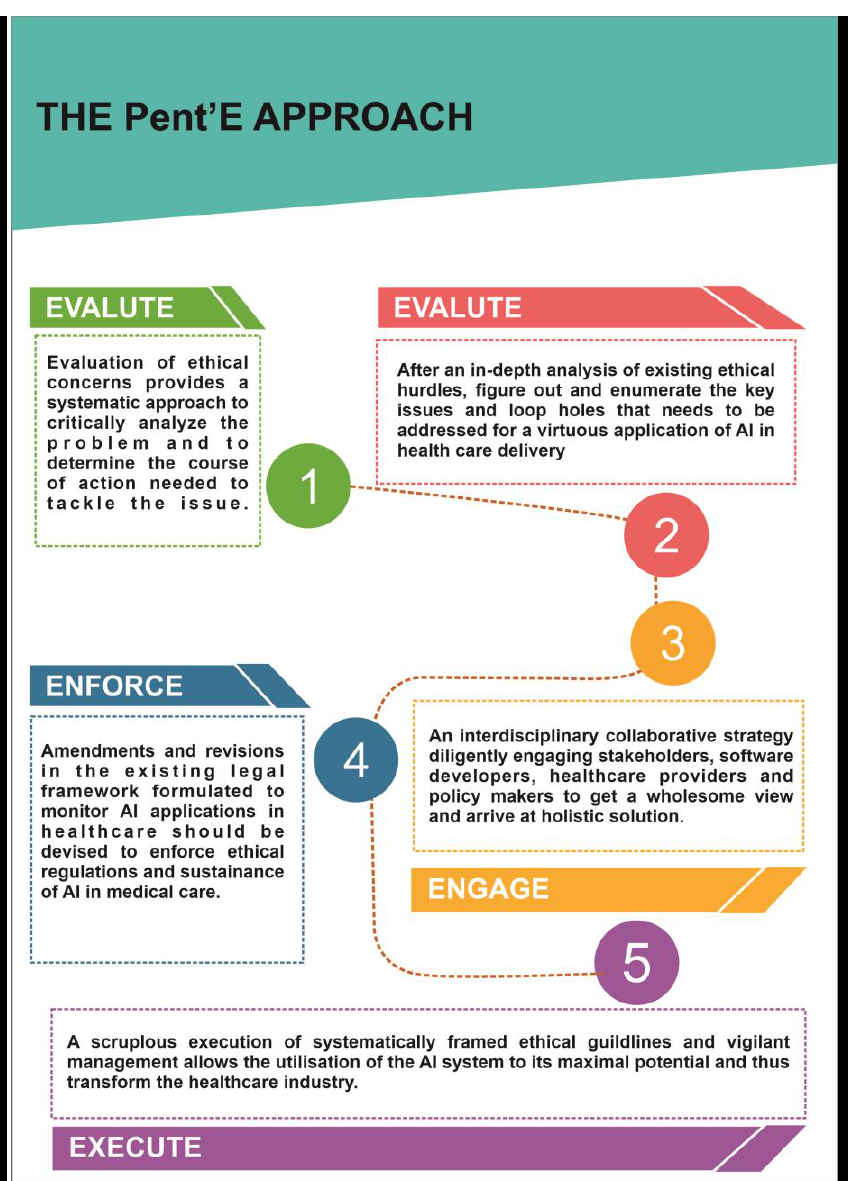
Figure 5. Enumerates the Pent’E approach of resolving ethical challenges in the application of AI in healthcare.